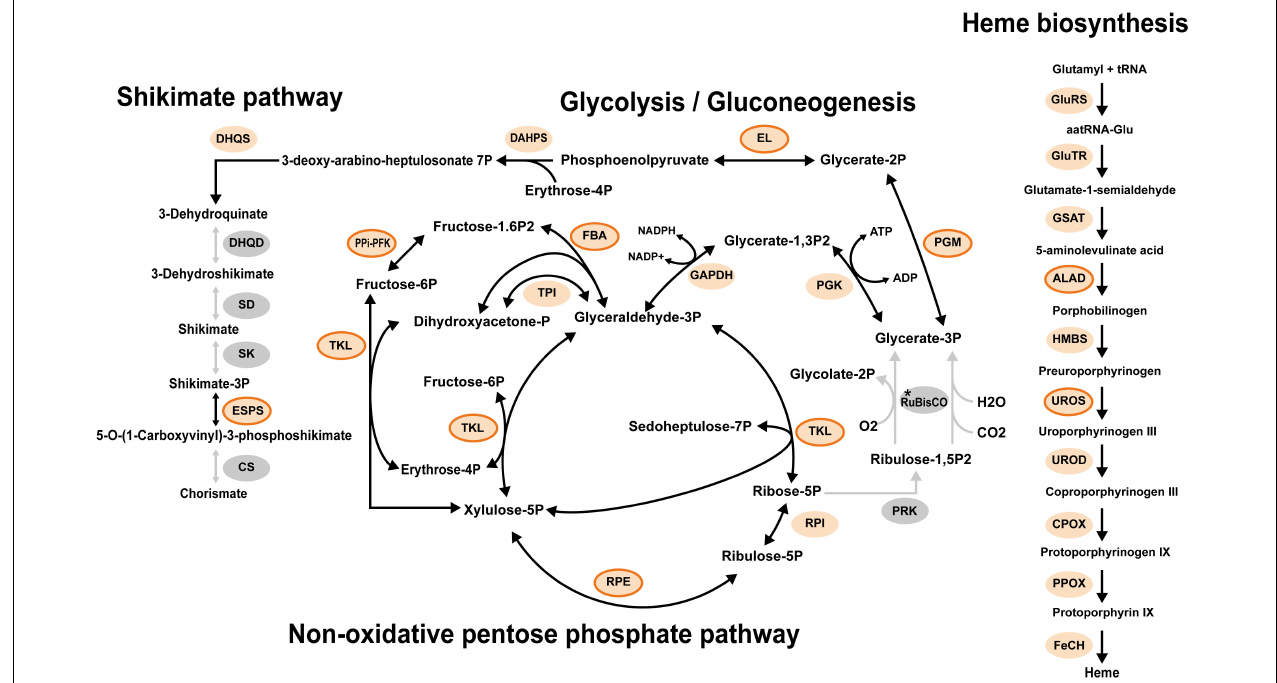
FIGURE 5 | Representative metabolisms of the plastid in Pteridomonas danica strain PT. Light orange circles enclosed by an orange line show proteins with the detectable plastid targeting signals. Light orange circles with no line show proteins with no detectable plastid targeting signal probably due to lack of 5 (cid:48) termini of sequences in the transcriptome data. Gray circles show proteins not detected. The asterisk shows that it is unclear whether RuBisCO is present as both large and small subunits of RuBisCO are plastid-encoded proteins; A plastid genome of strain PT is unavailable. ALAD, delta-aminolevulinic acid dehydratase; CPOX, coproporphyrinogen oxidase; CS, chorismate synthase; DAHPS, 3-deoxy-7-phosphoheptulonate synthase; DHQD, bifunctional 3-dehydroquinate dehydratase; DHQS, 3-dehydroquinate synthase; EL, enolase; ESPS, 3-phosphoshikimate 1-carboxyvinyltransferase; FBA, fructose 1,6-bisphosphate aldolase; FeCH, ferrochelatase; GAPDH, glyceraldehyde 3-phosphate dehydrogenase; GluRS, glutamyl tRNA synthase; GluTR, glutamyl tRNA reductase; GSAT, glutamate-1-semialdehyde aminotransferase; HMBS, hydroxymethylbilane synthase; PGK, phosphoglycerate kinase; PGM, phosphoglycerate mutase; PPi-PFK, pyrophosphate-dependent phosphofructokinase; PPOX, protoporphyrinogen oxidase; PRK, phosphoribulokinase; RuBisCO, ribulose-1,5-bisphosphate carboxylase/oxygenase large and small subunits; RPE, ribulose 5-phosphate 3-epimerase; RPI, ribose 5-phosphate isomerase; SD, shikimate dehydrogenase; SK, shikimate kinase; TAL, transaldolase; TKL, transketolase; TPI, triosephosphate isomerase; UROD, uroporphyrinogen decarboxylase; UROS, uroporphyrinogen III synthase.